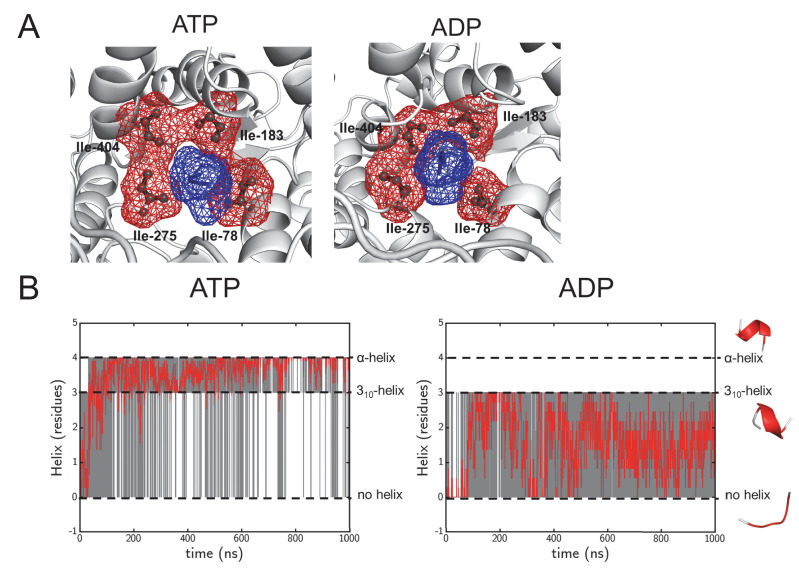
Structural highlights from the simulation data.(A) As Figure 1—figure supplement 1A, but of the pore ring in the ADP- and ATP-bound simulations, using a 1 μs snap shot as an illustration. The pore remains tightly clasped around the pre-protein, making it a good system to study cross-pore asymmetry. (B) Following helix formation in the pre-protein during equilibrium MD. The raw data is shown in grey, and will either have a value of 0 (no helix), 3 (310-helix) or 4 (α-helix). On the right are examples of each state, taken from the same region of pre-protein in the ATP and ADP simulations. To increase the clarity of the data, a Savitzky-Golay smoothed data line is shown in red. After 100 ns the ATP state largely switches between 310-helix and α-helix, whereas the ADP state samples the no-helix conformation considerably.